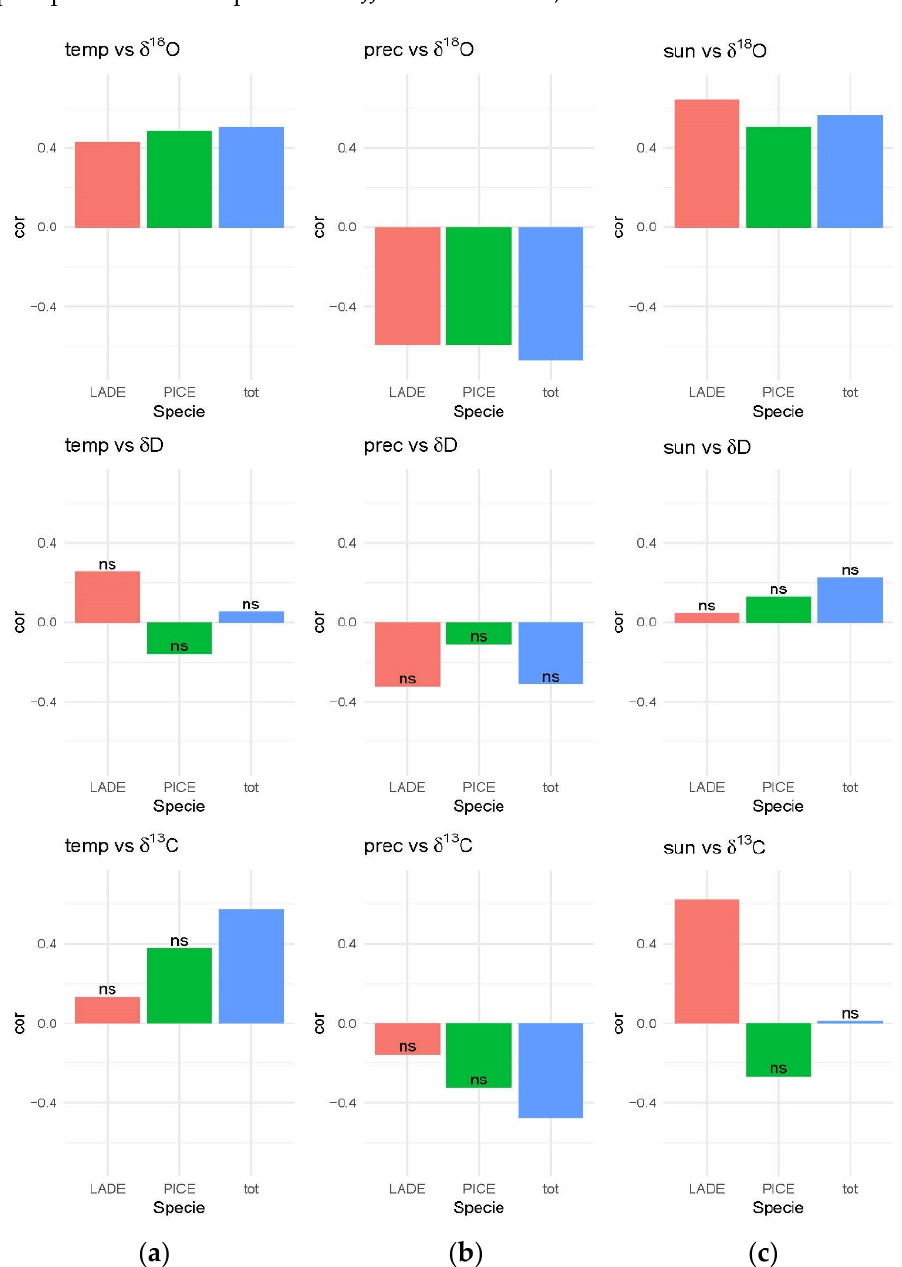
Figure 9. Climate correlations of cellulose isotopes: Pearson’s correlation coefficient between the mean of 5 years of ( a ) temperature anomaly, ( b ) precipitation anomaly, and ( c ) mean sunshine duration from the HISTALP database [68] with cellulose isotopes with 5-year time resolution; for oxygen, the two species were merged (blue) in the larch (LADE, orange) and cembran pine (PICE, green). The data are from 1880 to 1970 CE for temperature and precipitation, and from 1880 to 1970 CE for mean sunshine duration; ns: non-significant.